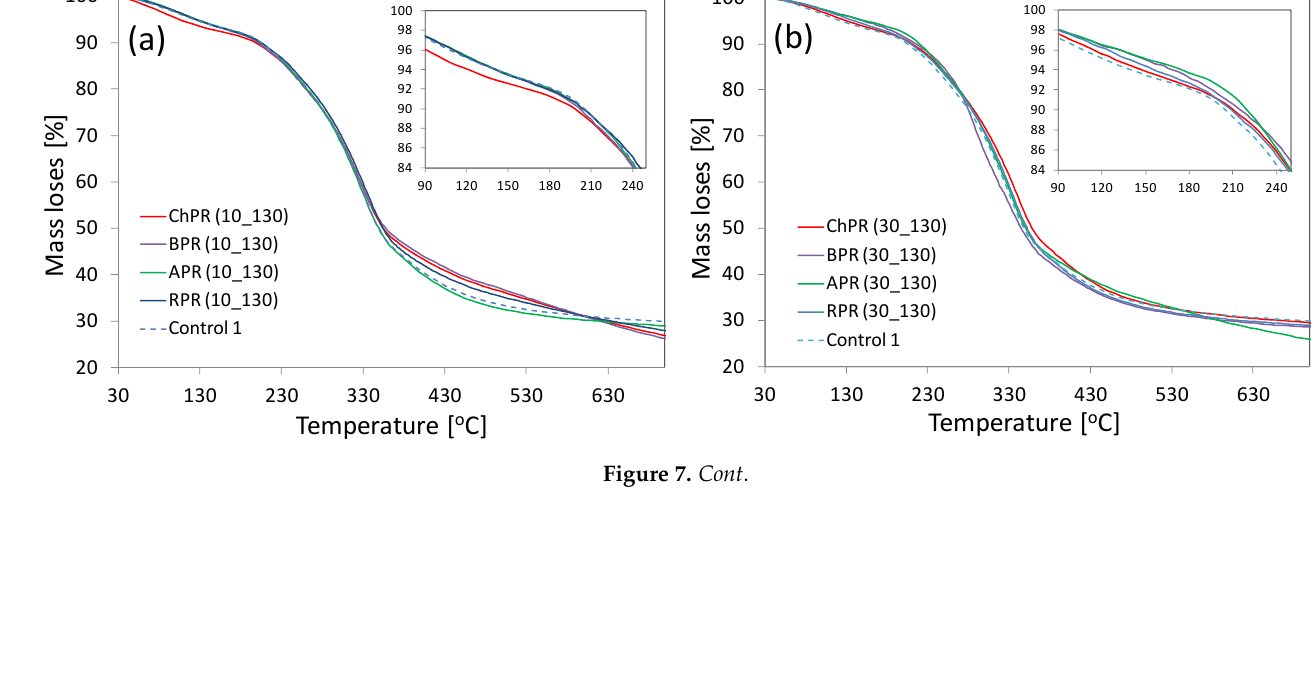
Figure 6. Scanning electron microscope (SEM) images of selected biocomposite samples: ( a ) sam- ple fracture site ChPR (30_130), ( b ) sample fracture site ChPR (30_160), ( c ) sample surface ChPR (30_160), ( d ) close-up of the fibre embedded in the matrix ChPR (30_160), ( e ) sample (control 1), ( f )